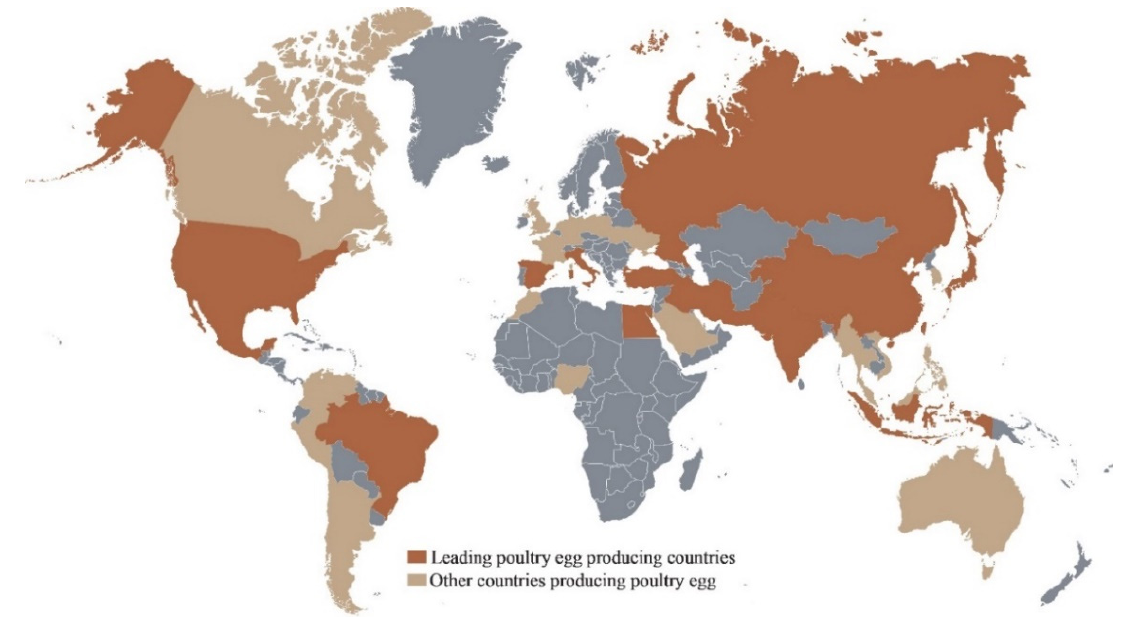
Figure 2. Global poultry egg-producing countries [4].